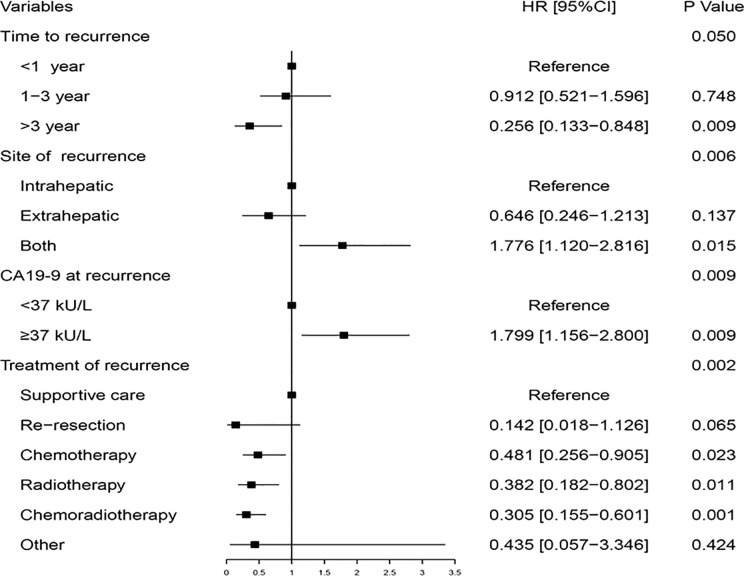
Multivariable analysis of the hazard ratio of post-recurrence survival in the training cohort.